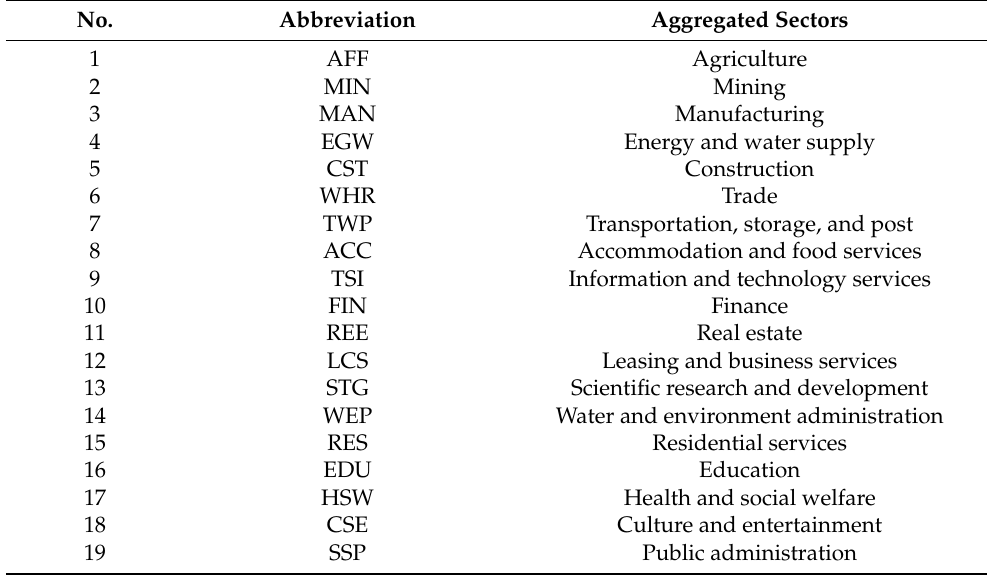
Table A1. The abbreviations of 19 aggregated sectors.